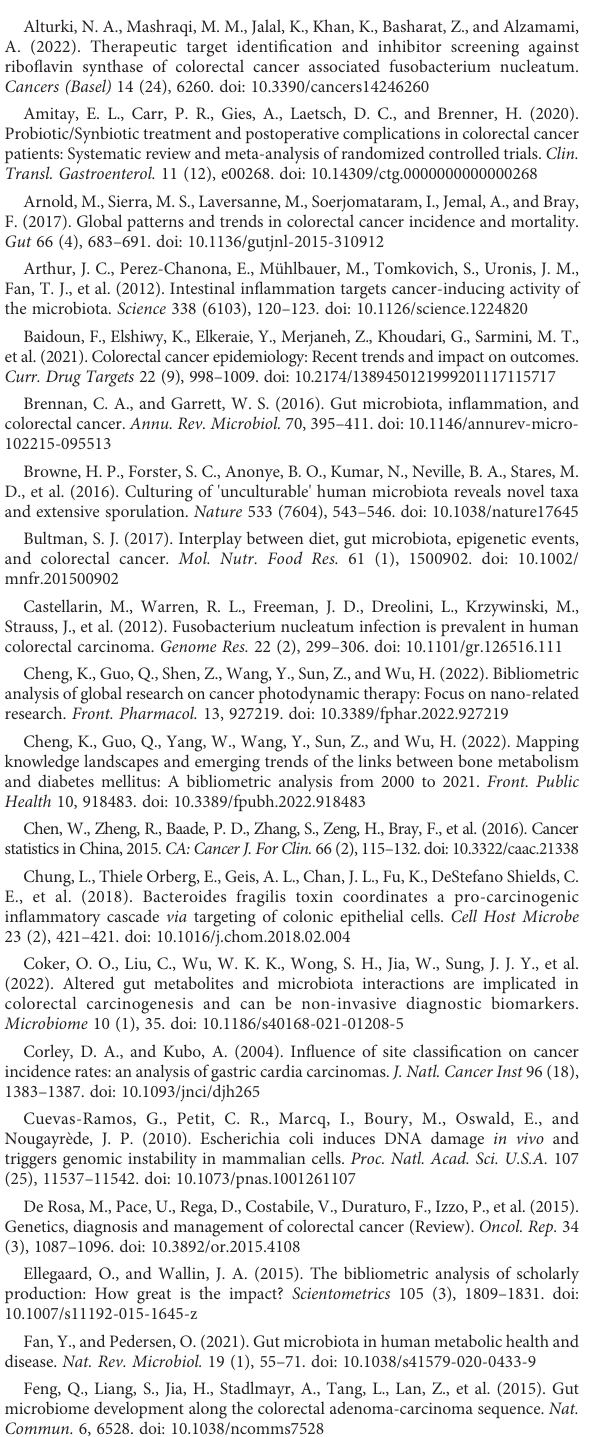
SUPPLEMENTARY TABLE 2 The top 10 most productive institutions in the fi eld of microbiota and colorectal cancer research from 2001-2021.